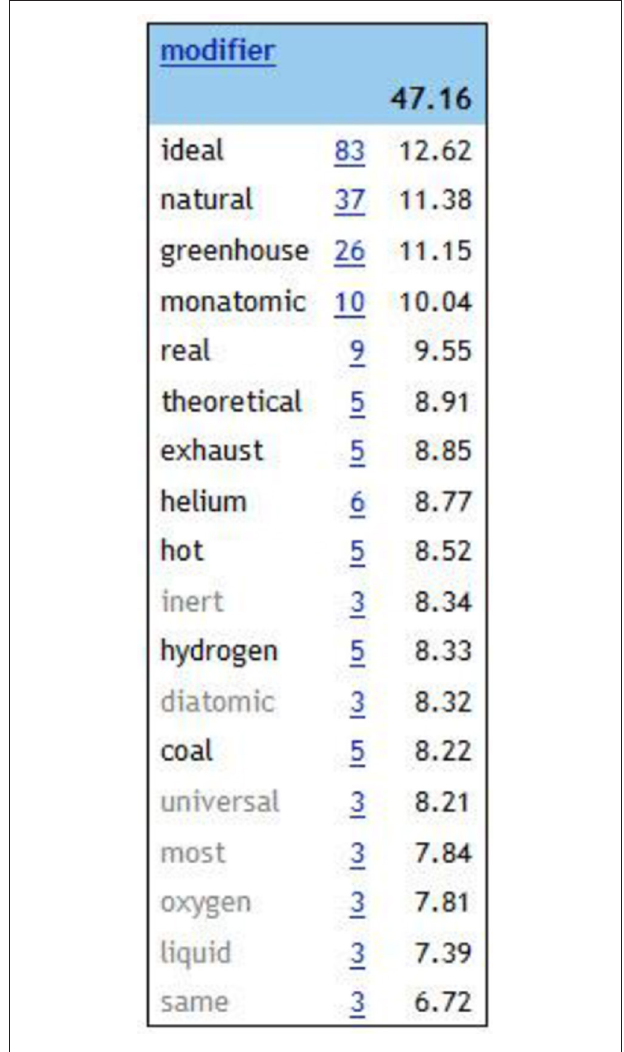
FIGURE 5 | Word sketch gas